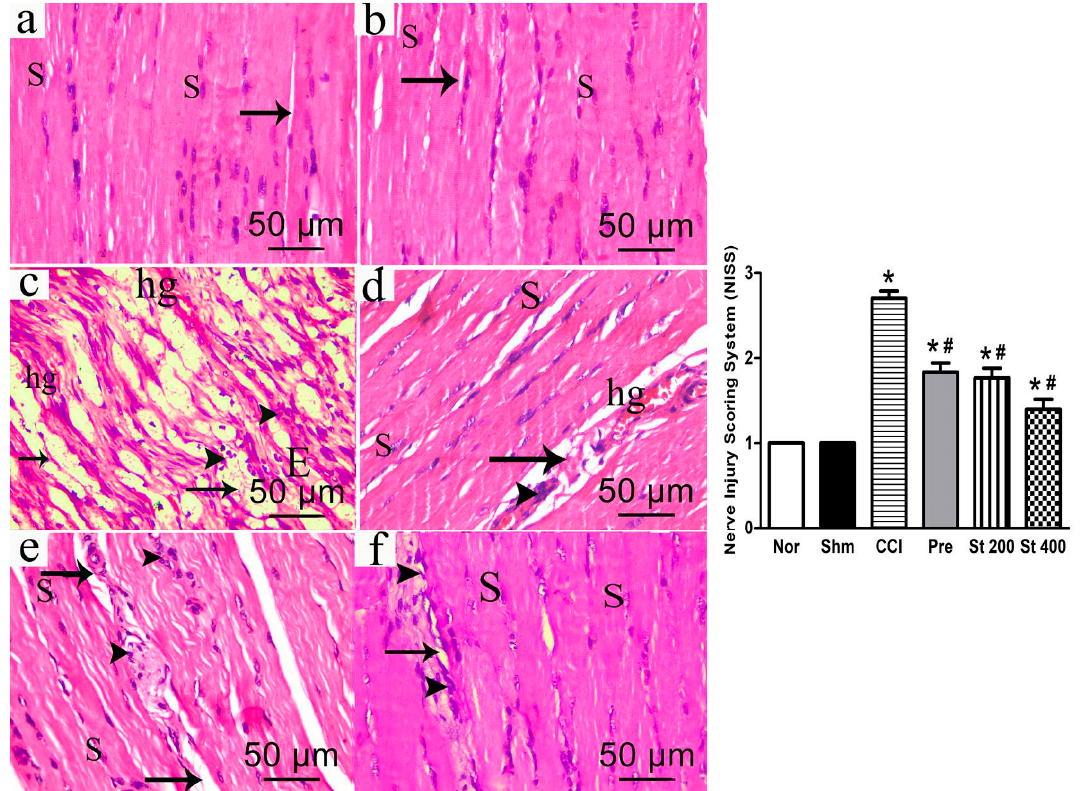
Figure 6. Upper panels: Photomicrograph (hematoxylin and eosin (H&E × 400) of longitudinal sciatic nerve sections from: Normal ( a ); Sham ( b ); CCI ( c ); Pregabalin ( d ) Extract (200 mg/kg, p.o.) ( e ); Extract (400 mg/kg, p.o.) ( f ). Rats received different treatments for 14 days after which the animals were sacrificed, and tissues were collected. Arrowheads indicate myelin sheets degeneration and mononuclear infiltrating cells respectively. S; Schwann cell nuclei, E; exudate; hg, hemorrhage; Scale bar, 50 μ m. Lower panel: quantification of myelin damage of sciatic nerves of different groups represented in figures a-f using Nerve Injury Scoring System (NISS), as follows: score 1, normal, mild degeneration or demyelination; 2, moderate level of degeneration or < 50% damaged nerve tissue and 3, diffuse degeneration or demyelination > 50% damaged nerve tissue. * p < 0.05 vs. control values; # p < 0.05 vs. CCI group. Norm means normal group; Shm means Sham group; St 200 and St 400 mean S. tetrasperma extract (200 and 400 mg/kg) and pre means pregabalin group .